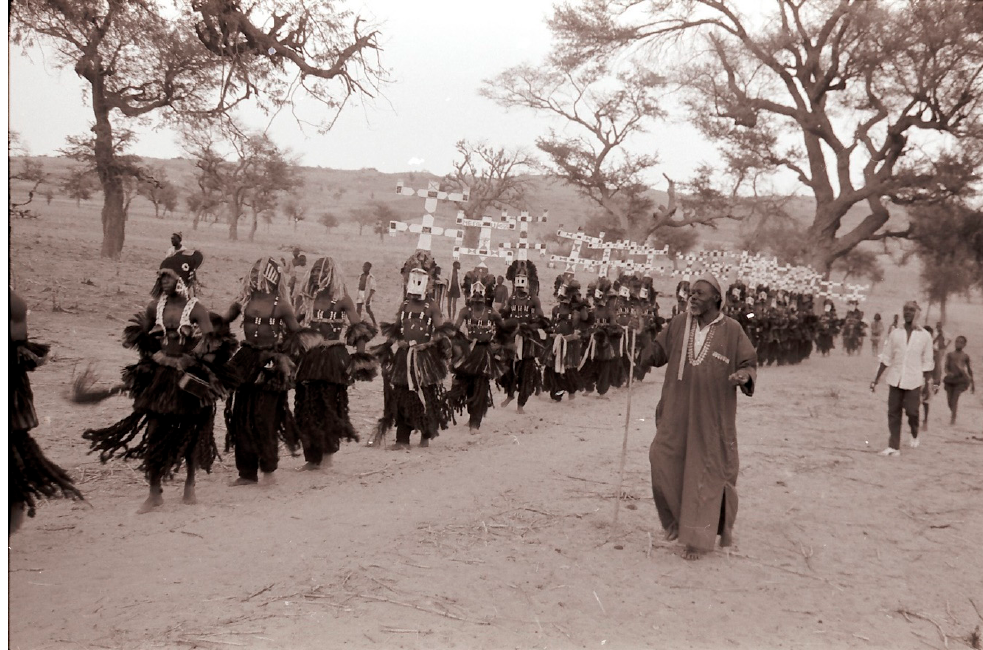
Figure 2. Men from Tireli accompanying the kanaga section of the Amani masks, 1989. Note the ‘naked’ masks in front.